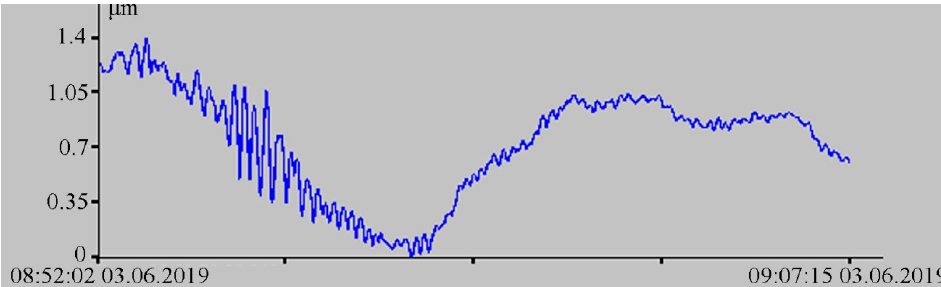
Figure 11. Fragment of the 52.5 m laser strainmeter record.